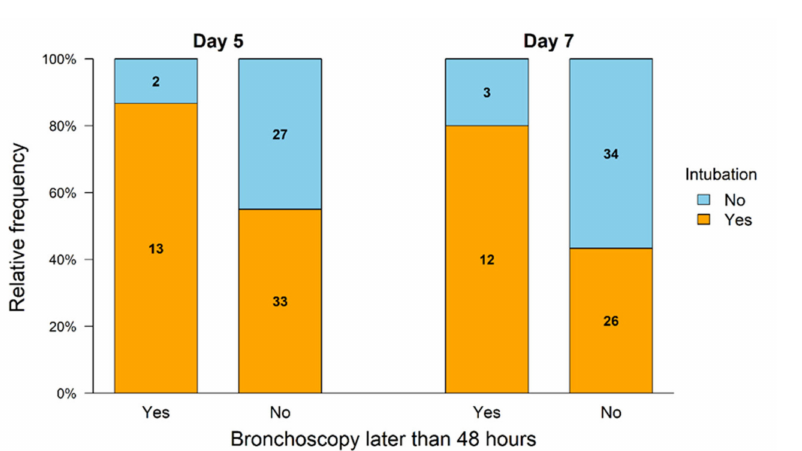
Figure 2. Intubation status of the surviving patients after OHCA. The group with early bronchoscopy <48 h showed a significantly higher proportion of extubation on day 5 ( p = 0.036) and day 7 ( p = 0.019) after OHCA compared to the group with later